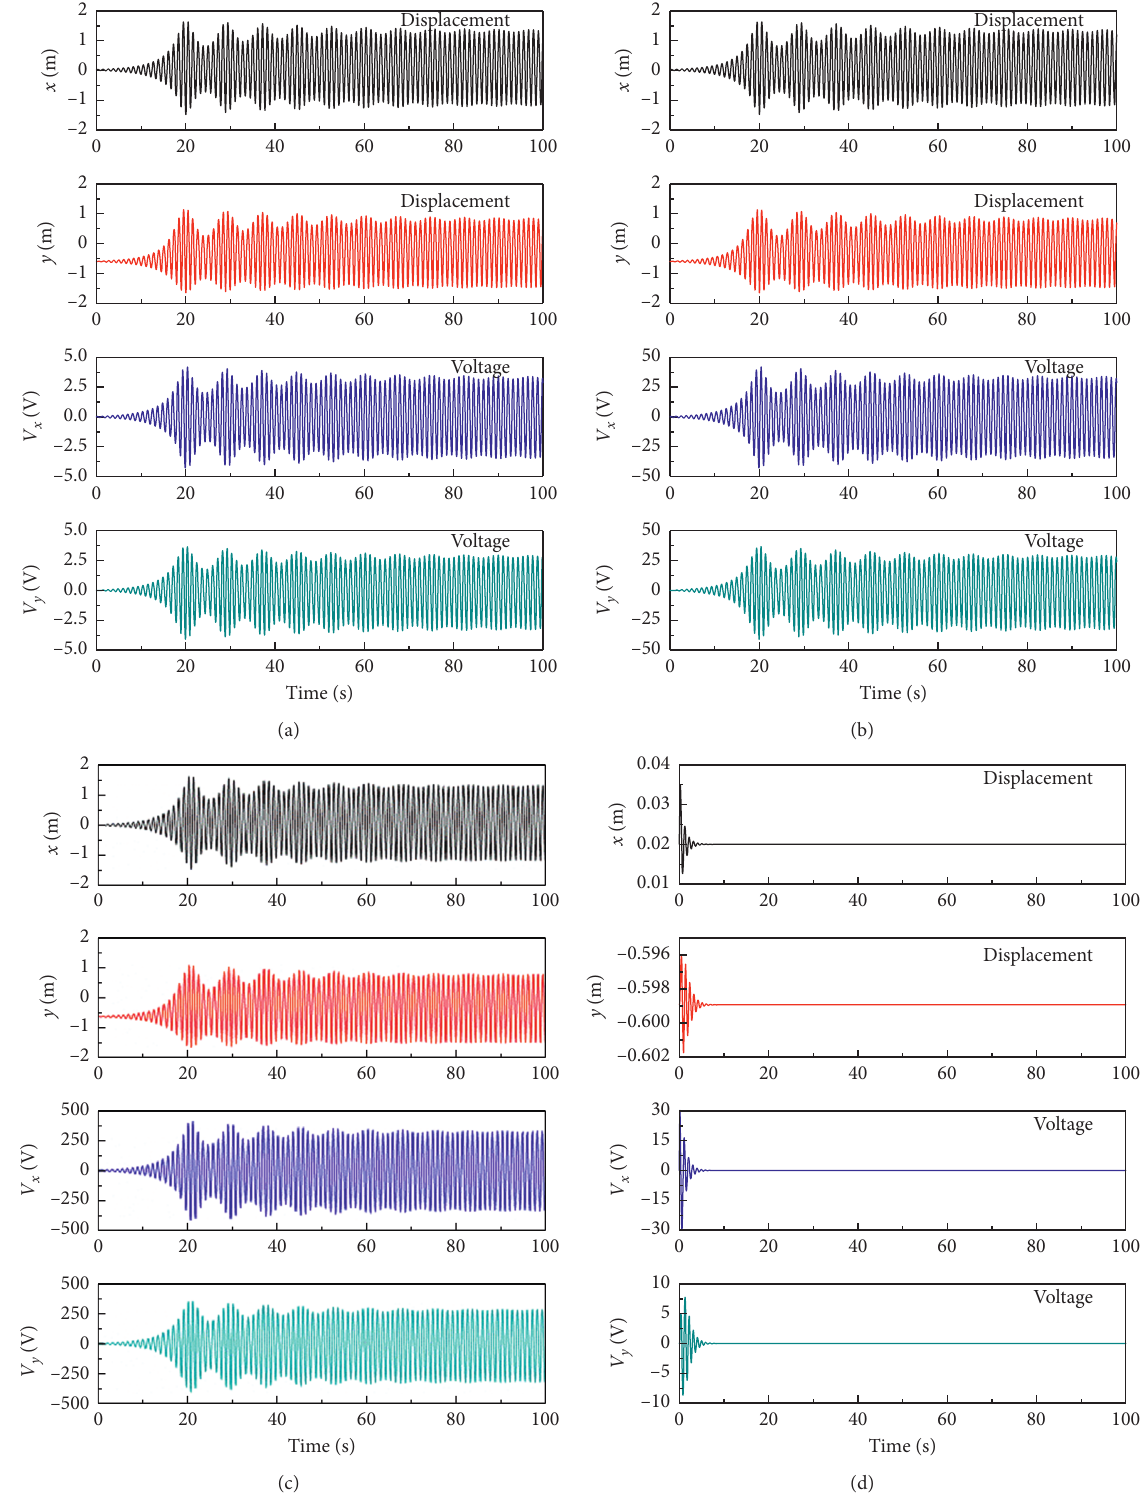
Figure 29: Ignoring separation, the displacements and output voltages of the friction system when the force factor of piezoelectric elements is α � 3.1 × 10 − 5 N/V (a), α � 3.1 × 10 − 4 N/V (b), α � 3.1 × 10 − 3 N/V (c), and α � 3.1 × 10 − 2 N/V